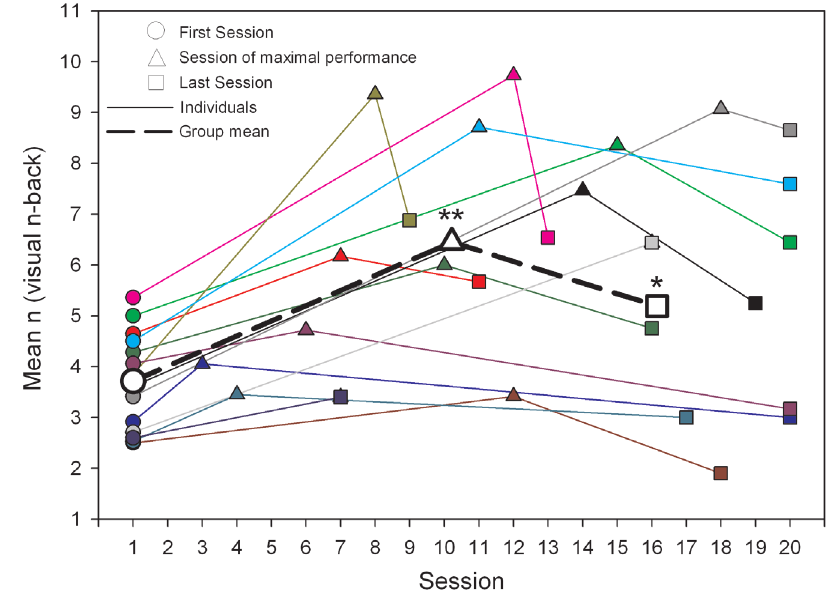
Figure 2. Individual training performance (first session, session of maximal performance, last session). Individual training performance (first session, session of maximal performance, last session) is shown. Each solid line represents the performance of an individual (N = 14) in the visuospatial n-back (VNB) task training mean n of VNB at the first training session (circle), at the session of maximal performance (triangle) and at the last training session (square). The dashed line represents the average performance at the first session, the session of maximal performance and the performance at the last session. Average maximal performance was reached between session 10 and 11 (mean 10.21 ± SEM 1.22) and average performance at the last session was reached between session 16 and 17 (16.14 ± 1.19). ** indicates: performance at session of maximal performance was significantly higher than performance at the first and the last training session. * indicates: performance at the last session was significantly higher than at the first